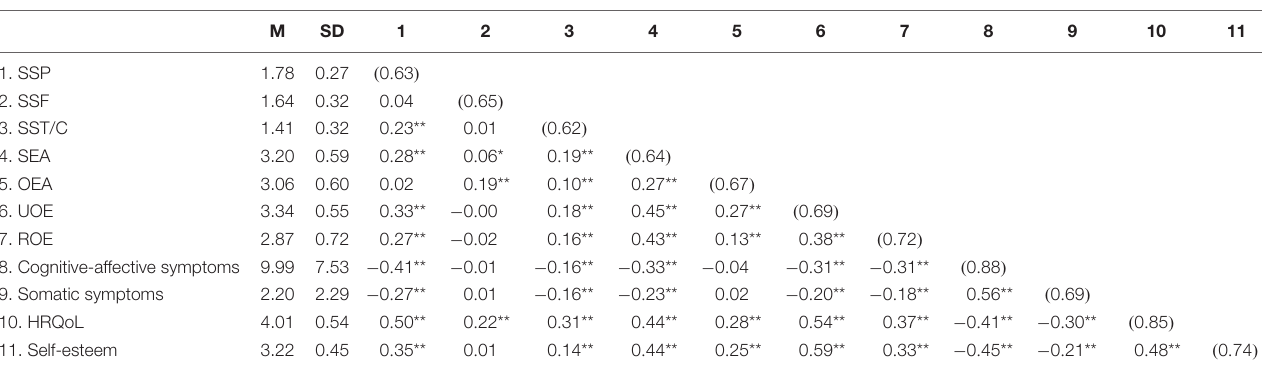
TABLE 1 | Means, SDs, and correlations between study variables and internal consistency